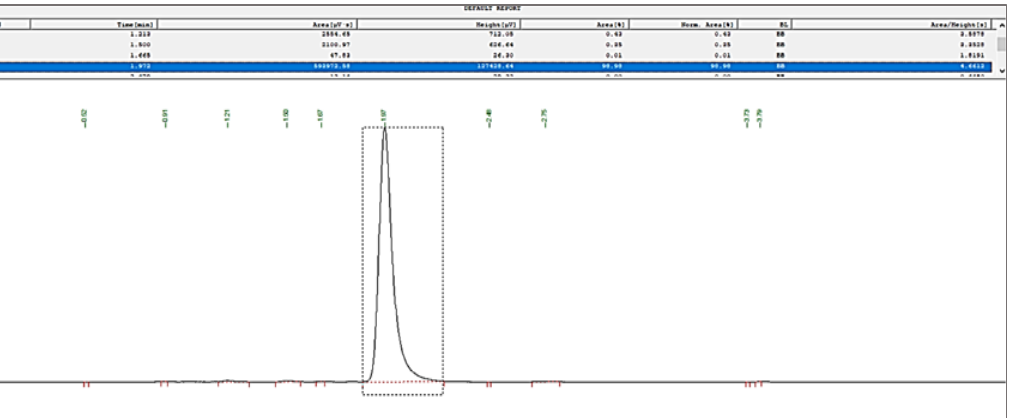
Figure 8. HPLC chromatogram of bergenin.